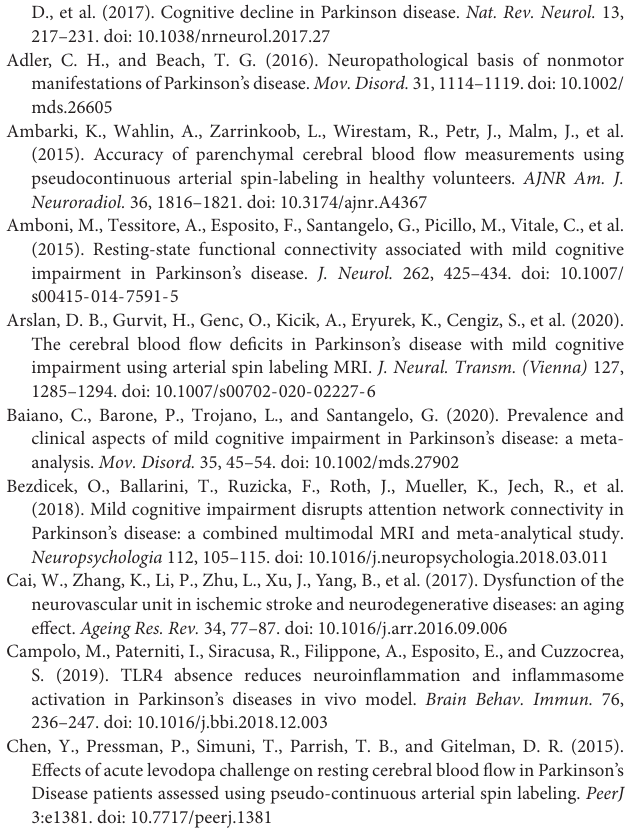
Supplementary Figure 1 | The brain regions with significant differences of ReHo among groups. The voxel-based analysis demonstrates the survived clusters among HC, PD-NC, and PD-MCI groups (A) , between HC and PD-NC groups (B) , and between HC and PD-MCI groups (C) . These clusters are referred to multiple comparisons correction using the FWE rate (a cluster-defining threshold of P = 0.001 and a corrected cluster significance of P < 0.05). The region with the significant difference among the three groups is shown with the warm color (for A ). The significantly increased ratio relative to HC in the group is shown with warm color, and the significantly decreased ratio relative to HC in the group is shown with cold color (for B,C ). ReHo, regional homogeneity; HC, healthy control; PD,